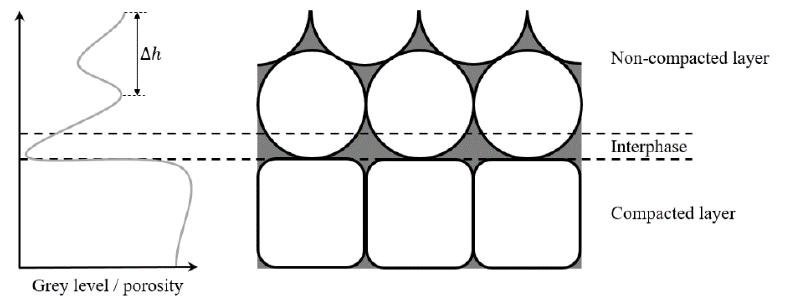
Figure 4. Schematics of particle and porosity distribution .